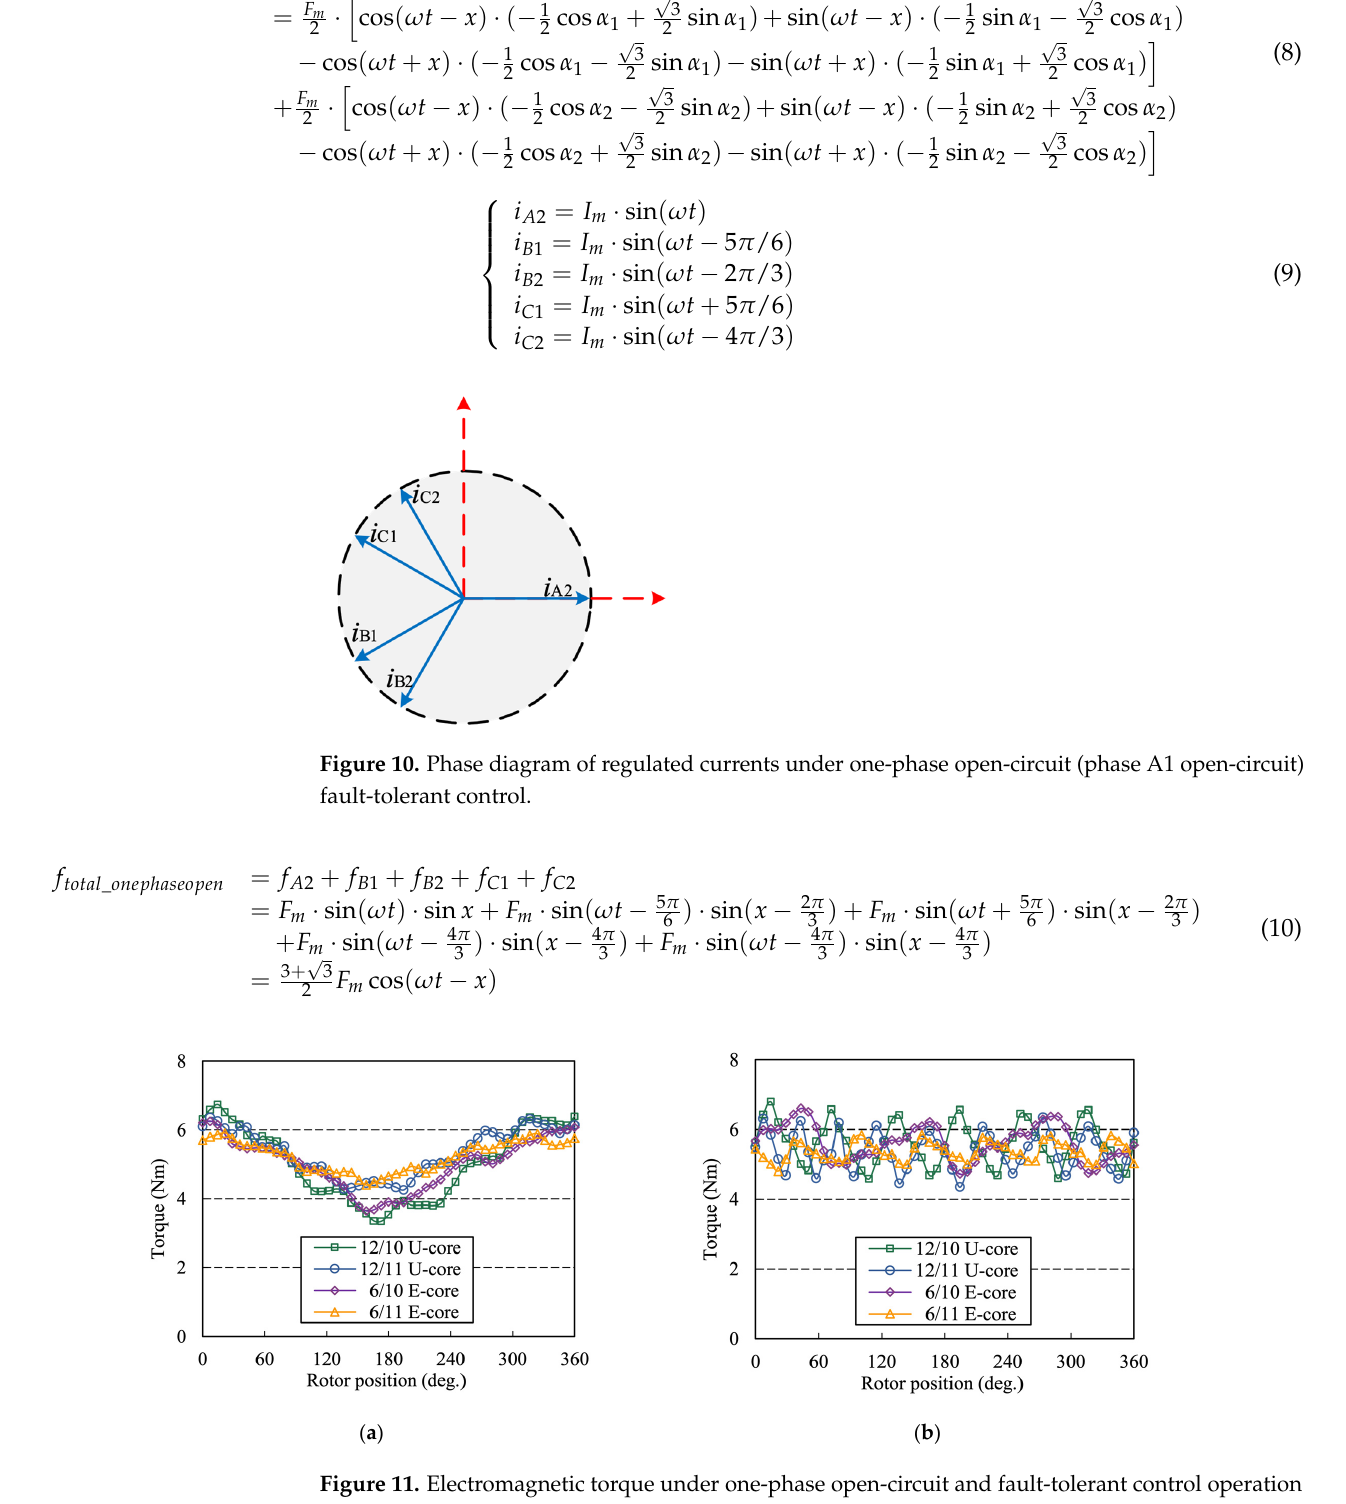
( a ) ( b ) Figure 12. Comparison of electromagnetic torque and torque ripple of four candidates. between healthy and one-phase open fault-tolerant control operation. ( a ) Average electromagnetic torque; ( b ) Torque ripple.